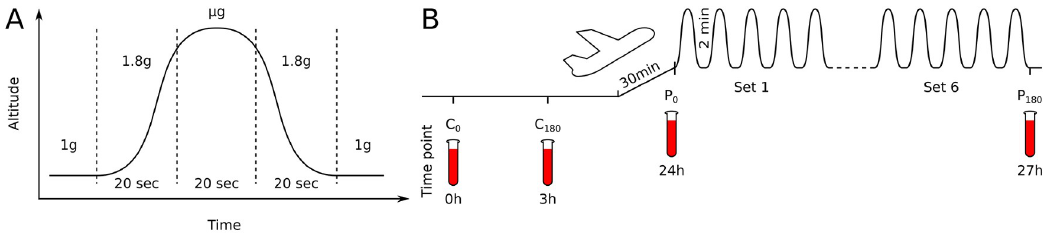
Fig 1. Course of a single parabolic maneuver and study scheme of immune cell analysis in human blood gravitational stress. (A) During a parabolic flight maneuver, gravitational stress appears during a 20 sec 1.8 g phase followed by a 20 sec μ g phase and another 20 sec 1.8 g phase. (B) Blood was taken from 18 participants the day before the parabolic flight maneuvers (C0 and C180) and during the flight—immediately before the 31-parabolic flight maneuvers were started (P0) and immediately thereafter